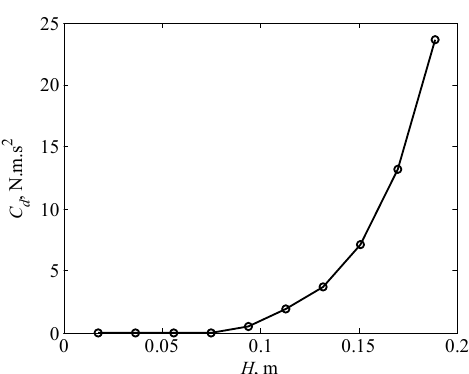
Figure 16. The drag torque coe ffi cient as a function of wave height at T = 1.6 s and c = 12 N · m · s / rad.